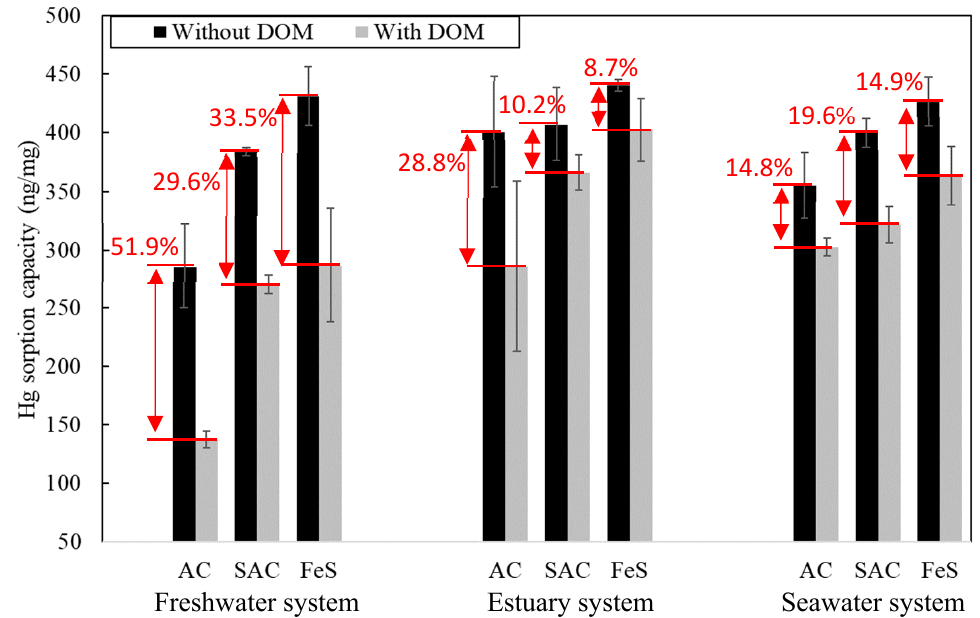
Figure 6. Comparison of the influence of various salinity levels and DOM on Hg sorption capacity in the aqueous batch experiments.